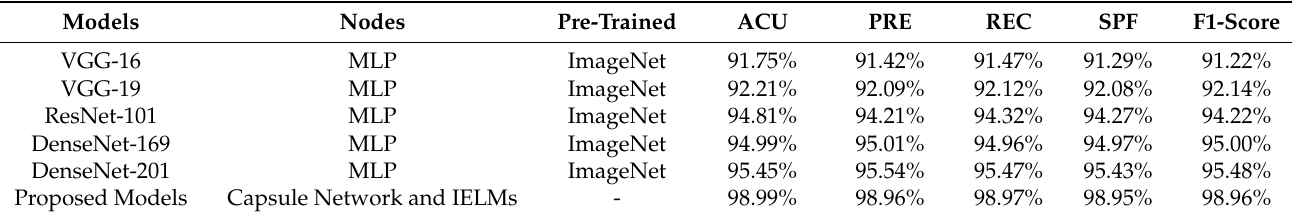
Table 4. Comparison of the proposed model with five DL Table 4 . Comparison of the proposed model with five DL models.